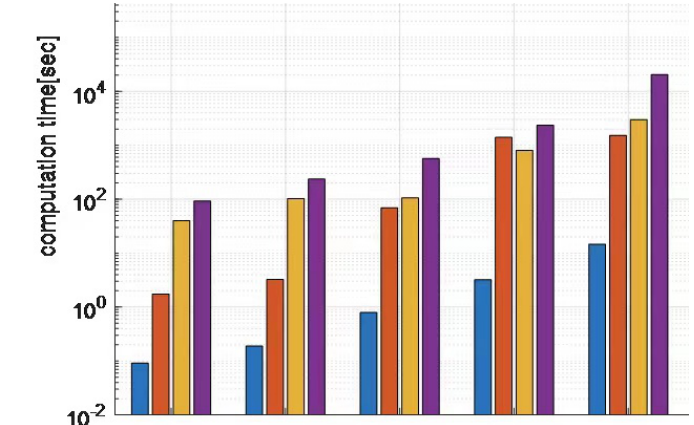
Figure 3. Comparison of computing time based on different methods, where “blue”, “orange”, “yel- low”, and “purple” refer, respectively, to the proposed model, LRTV [1], SPCTV [29], and SPCQV [29].